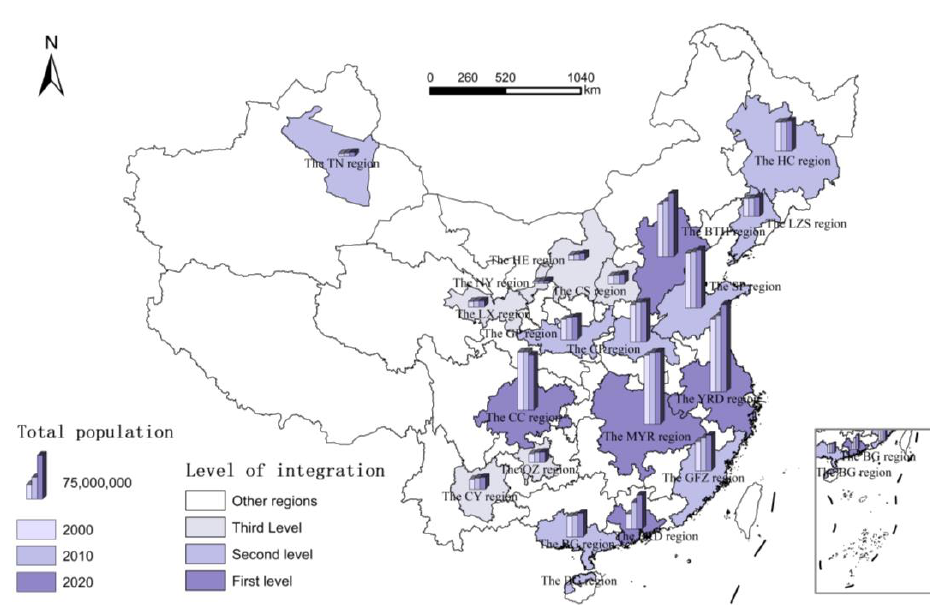
Figure 4. Regional Integration and Total Population (referring to the Outline of the 14th Five-Year